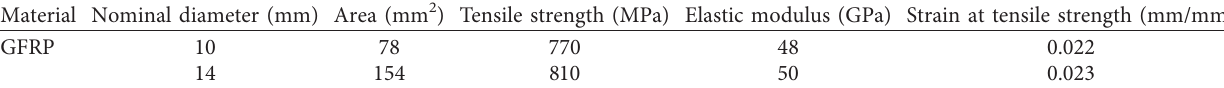
Table 2: Physical and mechanical properties of GFRP